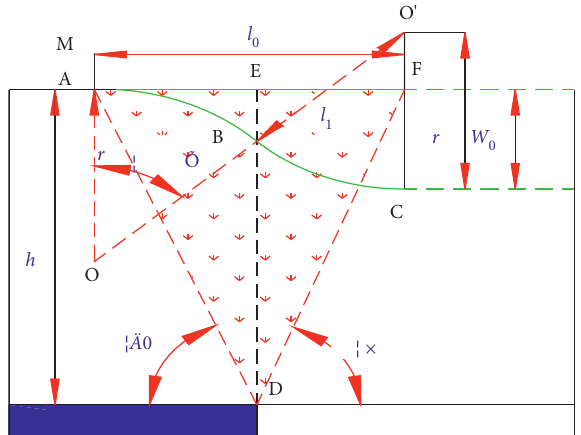
Figure 2: Geometric model of rock stratum bending and subsidence.